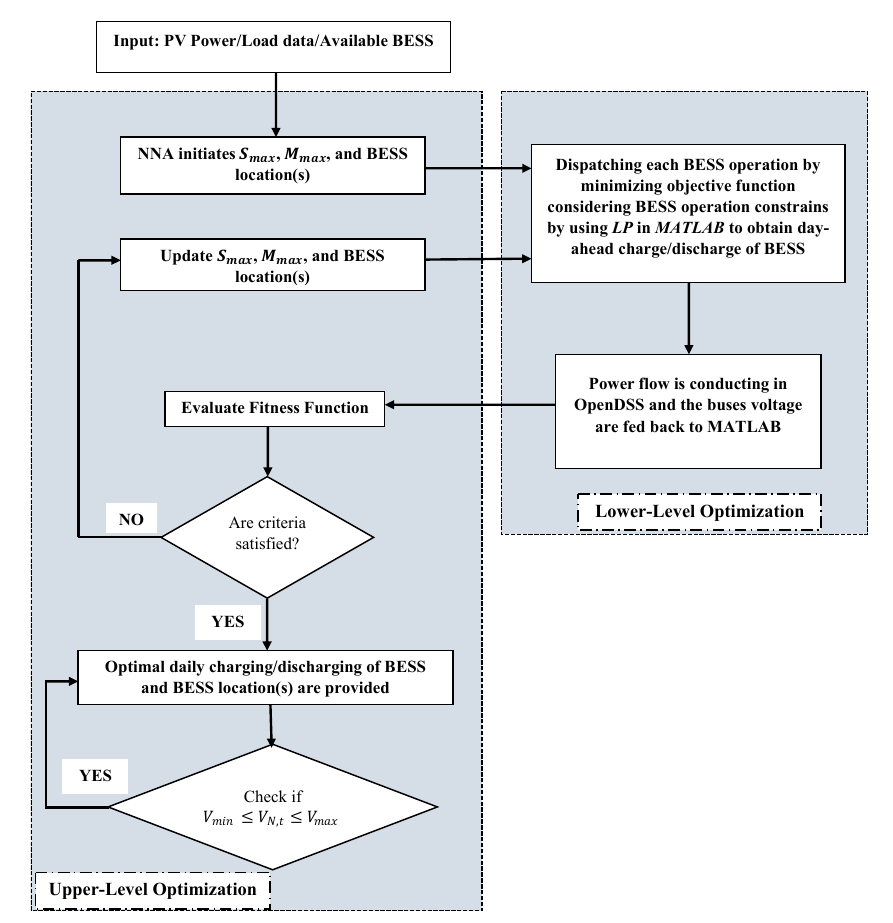
Figure 1. The framework of the voltage management strategy.